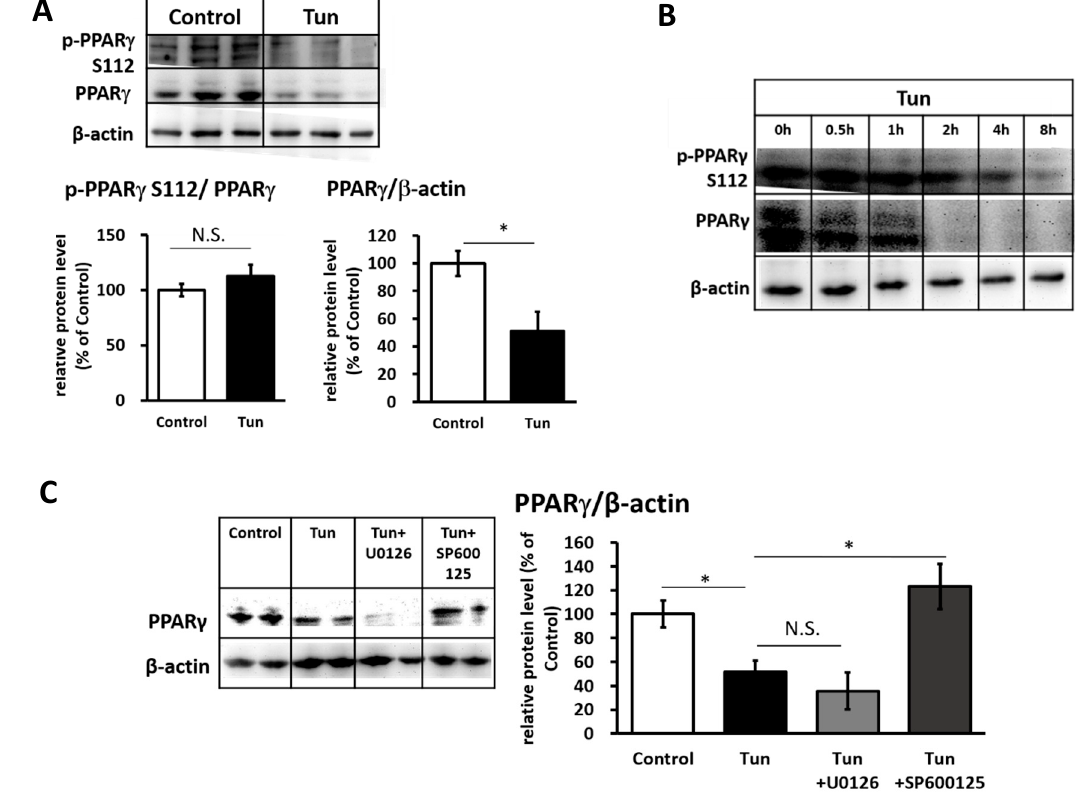
Figure 3. ER stress decreases Ppar γ protein level preferably through JNK pathway in IWAT cells. Ppar γ phosphorylation at serine 112 (S112) and Ppar γ protein level in cells treated with 1 µ M tunicamycin ( A ) for 12 h or ( B ) at different time points. ( C ) Ppar γ protein after treated with 100 µ M U0126 for 14 h or 25 µ M SP600125 for 13 h, followed by tunicamycin (1 µ M, 12 h). β -actin was used as a loading control. Data are presented as mean ± S.E.M. (error bars). n = 3–4 in each group. * indicates significant differences ( p < 0.05) according to unpaired- t test. N.S., not significant.